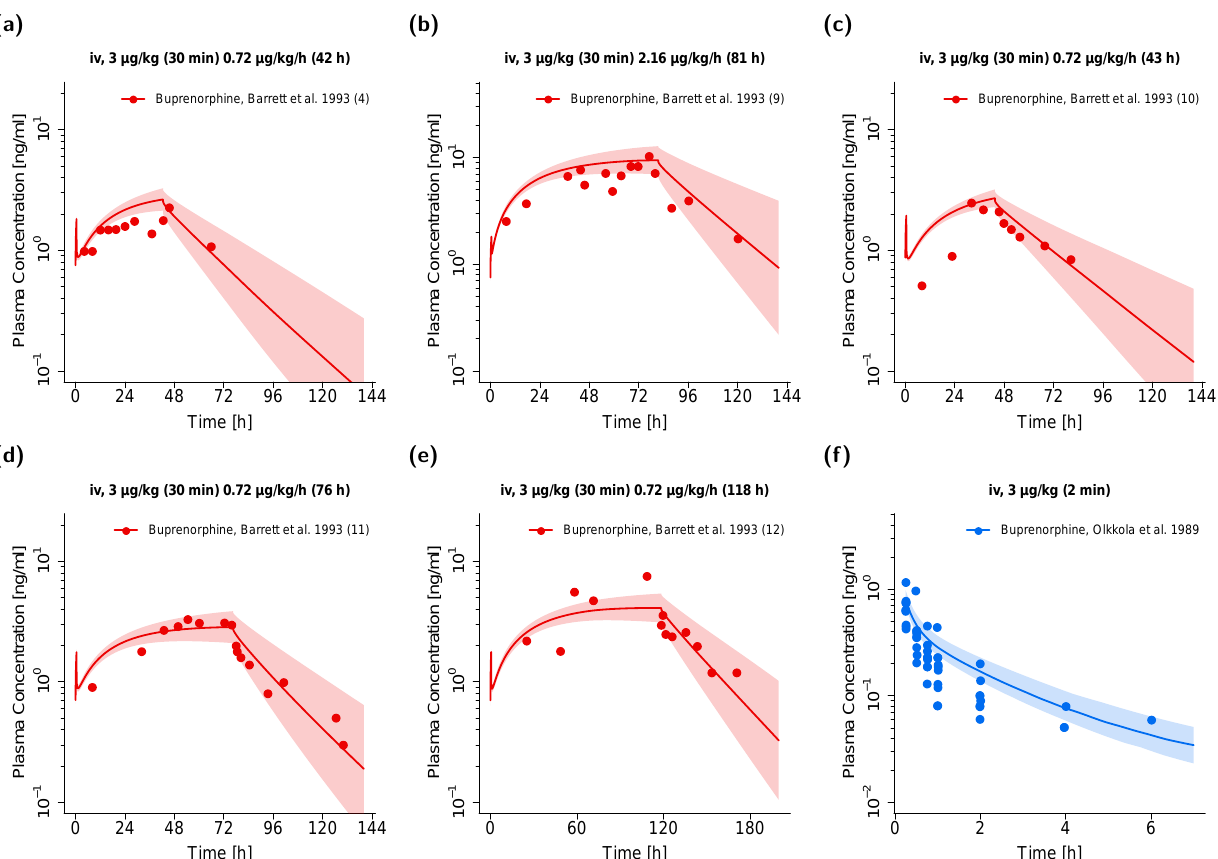
Figure 4. Buprenorphine (red: arterial blood, blue: venous blood) predicted and observed plasma concentration-time profiles after intravenous administration of buprenorphine in preterm neonates ( a – e ) and children ( f ). Population simulations (n = 100) are shown as lines with shaded areas. Observed data are shown as circles. References with numbers in parentheses link to a specific observed dataset described in Table 1 and Table S2 of the Supplementary Materials. Predicted and observed area under the plasma concentration-time curve from the first to the last data point (AUC last ) and maximum plasma concentration (C max ) values are compared in Table S6 of the Supplementary Materials. Predicted and observed plasma concentration-time profiles of all studies in pediatrics are shown in Section 4.2 of the Supplementary Materials both on a linear and a semilogarithmic scale. iv: